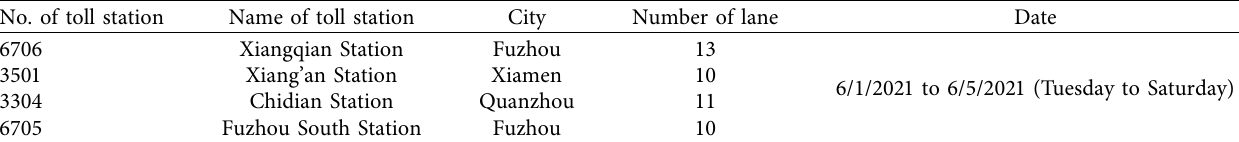
Table 1: Te details of the selected toll